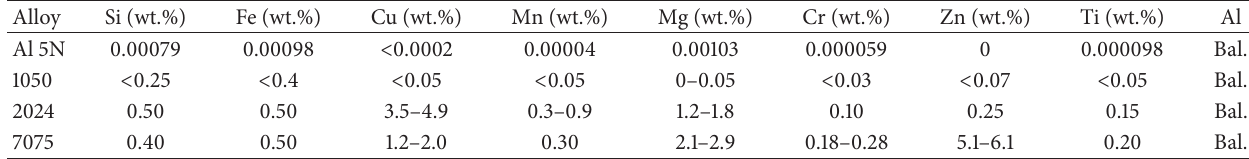
Table 1: Chemical composition of the studied materials according to the specification of the producer. Alloy Si (wt.%) Fe